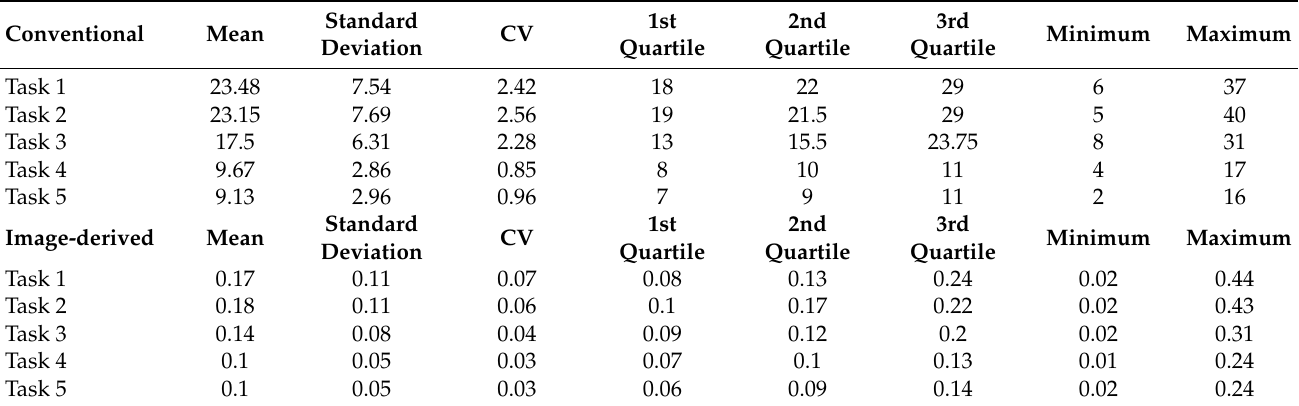
Table 2. Conventional and image-derived Luria-Nebraska Neuropsychological Battery (LNNB) test scores among 46 PHIME participants.